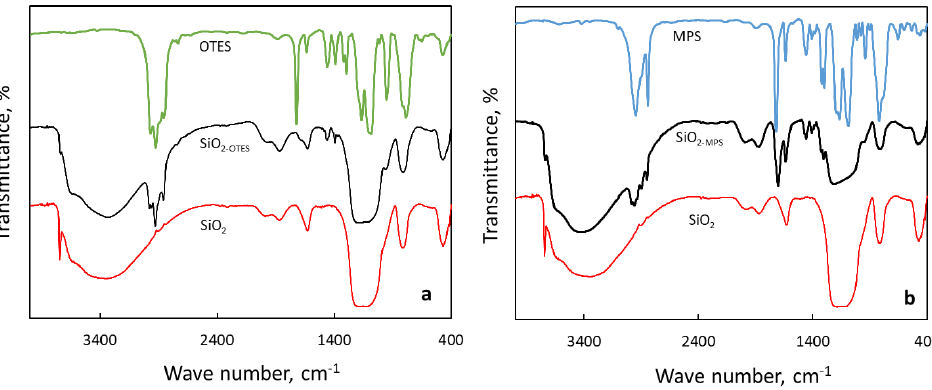
Figure 1. IR spectra of ( a ) SiO 2 , SiO 2 -OTES, and OTES, and ( b ) SiO 2 -MPS and MPS.